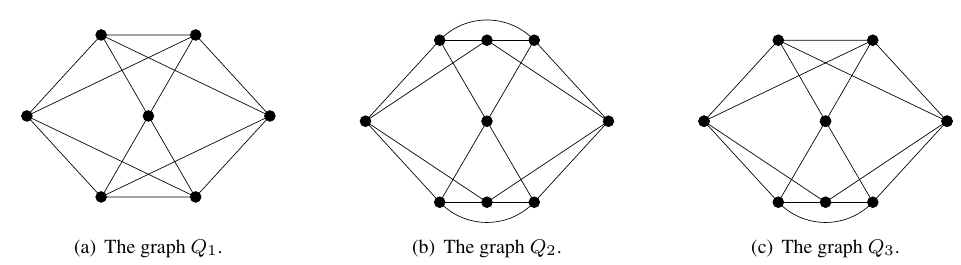
Fig. 1: The graphs Q 1 , Q 2 , and Q 3 , depicted above, are the only double- col -critical graphs with colouring number 5 which are not squares of